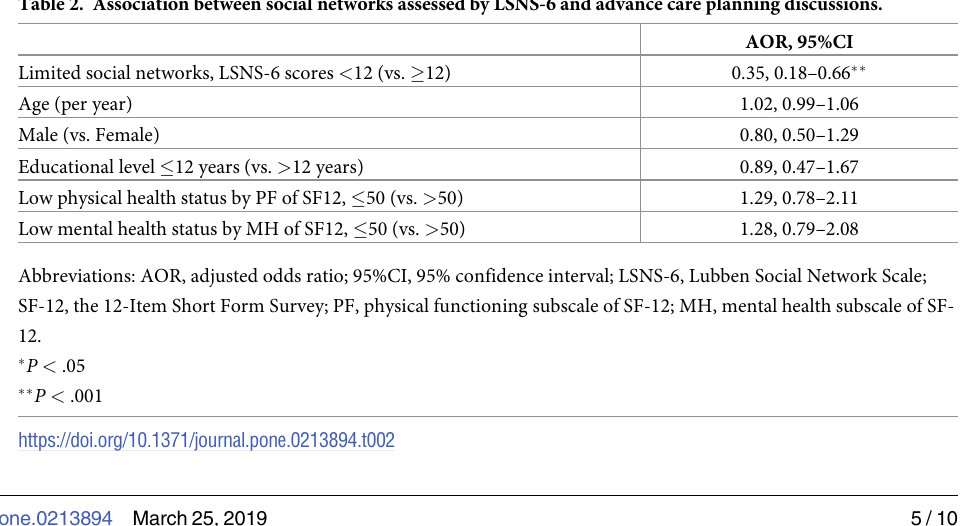
Table 2. Association between social networks assessed by LSNS-6 and advance care planning